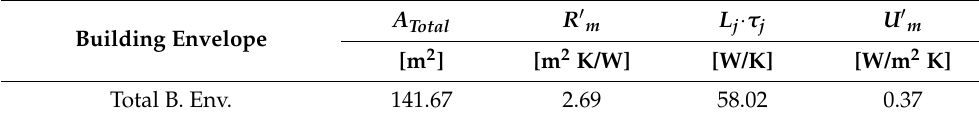
Table 6. The thermal coupling coefficient value per building envelope.